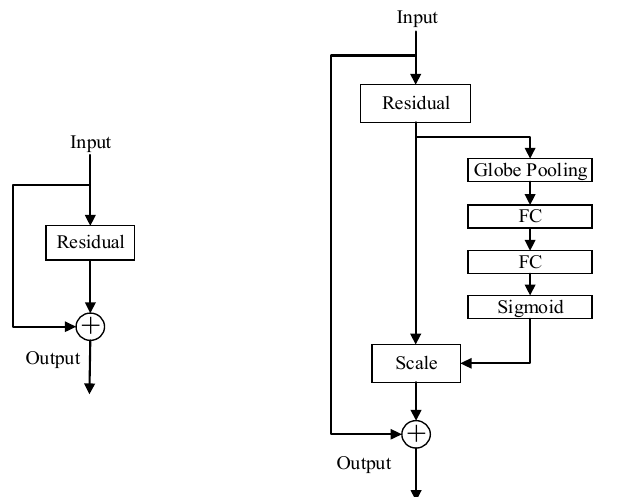
Figure 6. Schematic comparison of the residual blocks of ResNet-12 and SE ResNet-12.